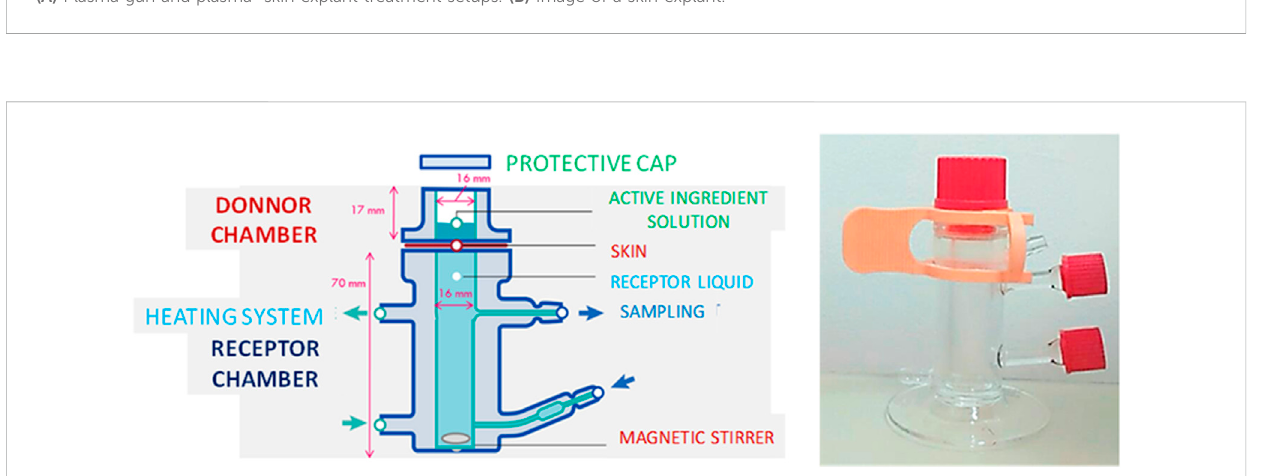
PhotographandFranz-cellsetupusedtomeasurethecaffeinediffusionacrosstheskinexplantsample(schematicadaptedfromBiogalenys,https://